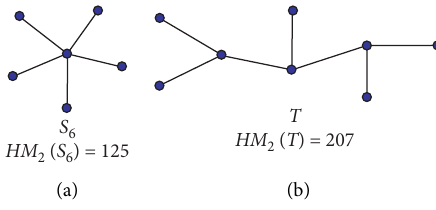
( G ) � 24, (b) G GO 0 1 0